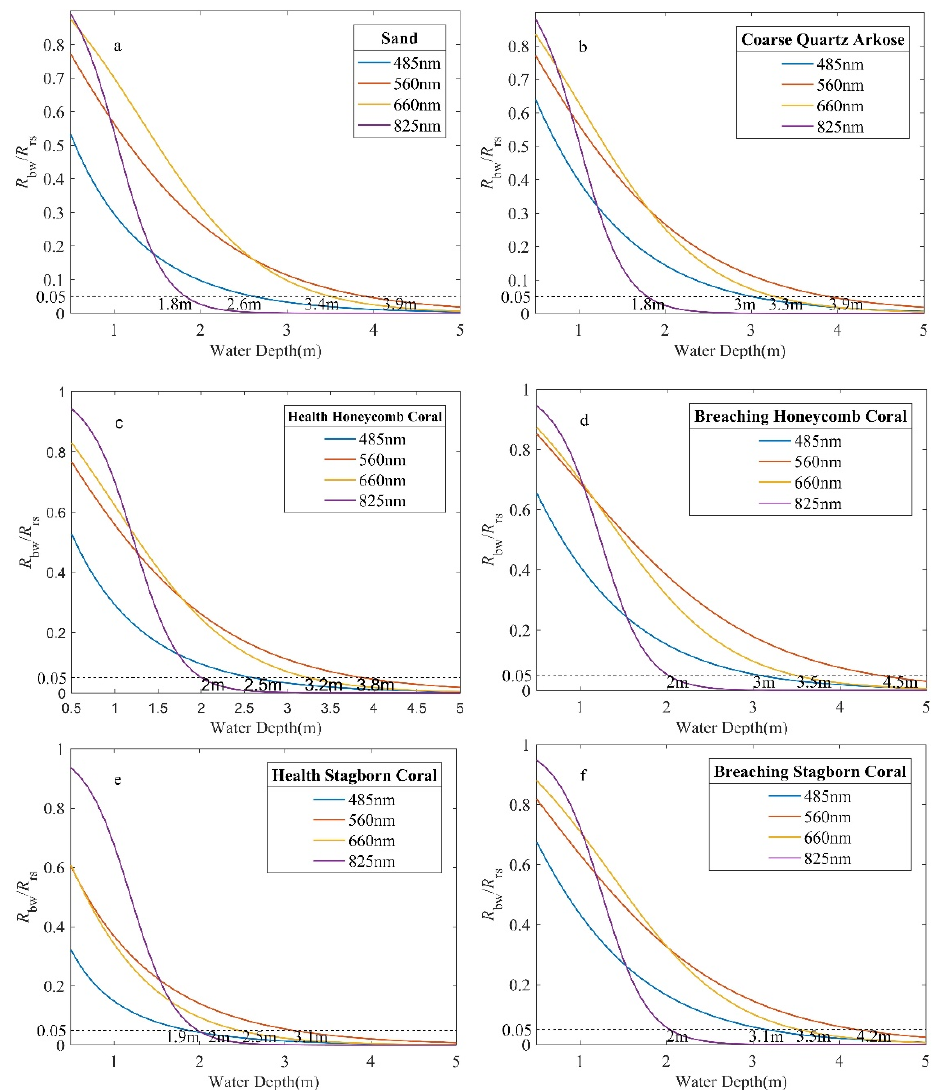
Figure 19. The effects of bottom reflectance (Rbw) on the Rrs (i.e., Rbw/R) of ( a ) sand, (b) coarse quartz arkose, ( c ) healthy honeycomb coral, ( d ) breaching honeycomb coral, ( e ) health stagborn coral, and ( f ) breaching stagborn coral. The black lines represent the ratio of Rbw/Rrs being equal to 0.05. The blue, orange, yellow, and purple lines represent SPOT6 band 1, band 2, band 3, and band 4. Although the blue light has the best penetration ability, the maximum of R bw occurs in the red band. The R bw in the NIR band is the lowest, the water depths that affect the remote sensing reflectance are less than 2 m, and the near-infrared band has the potential to retrieve the parameters of the water column in optically shallow waters. The green lines show the water depths when the ratio of R bw to remote sensing reflectance is equal to 5%, and the variations of the water depths on the green lines are independent of bottom types. In coastal waters, the R bw depends on the bottom